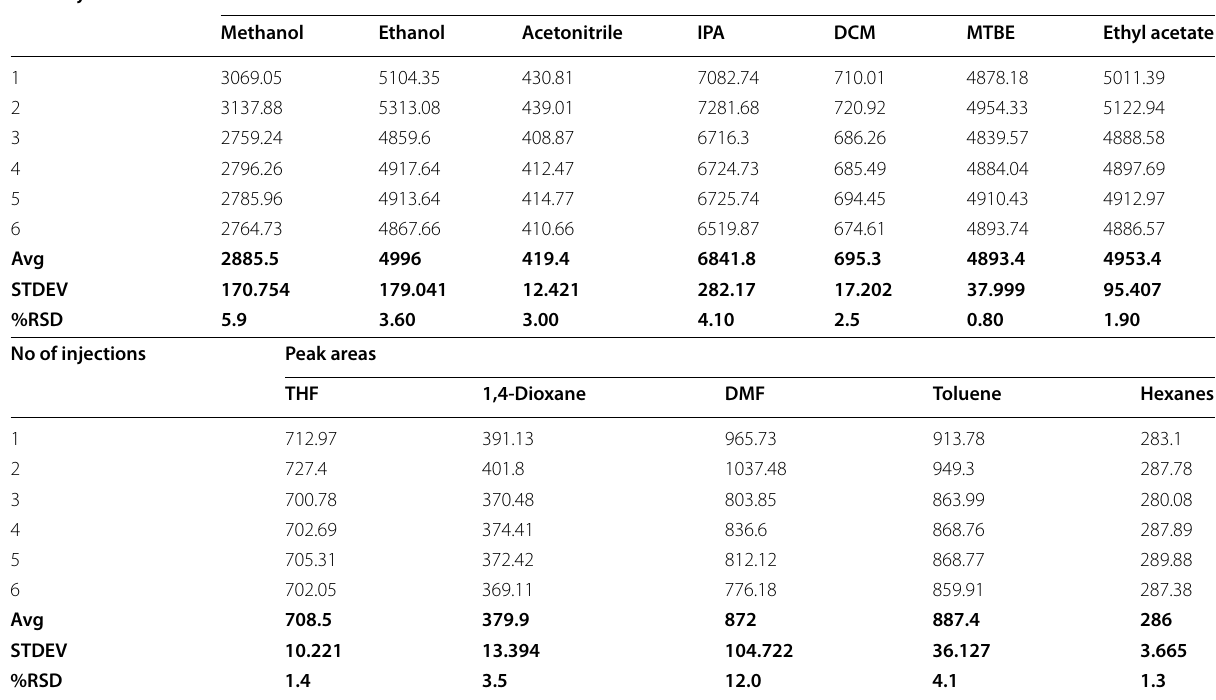
Table 3 Method precision data